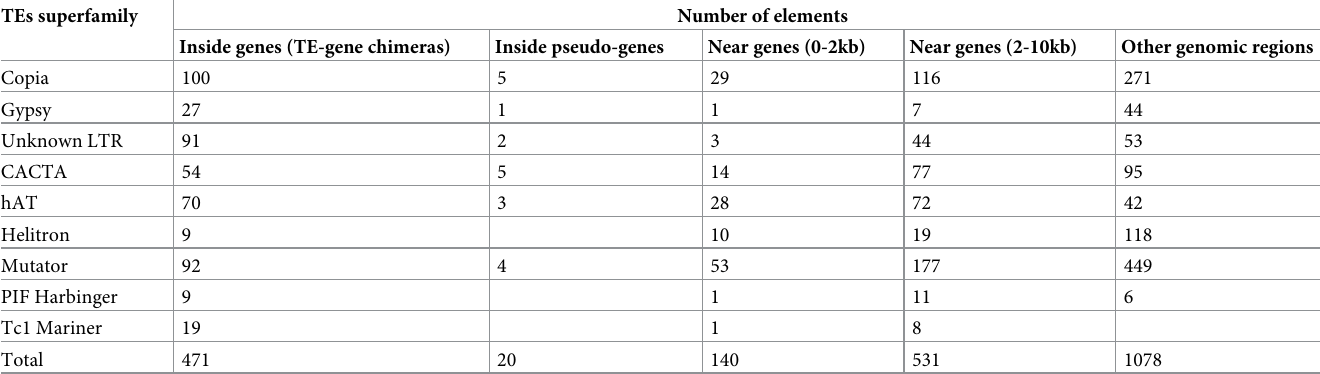
Table 2. Summary of the C . arietinum TEs that are positioned inside or nearby genes. TEs